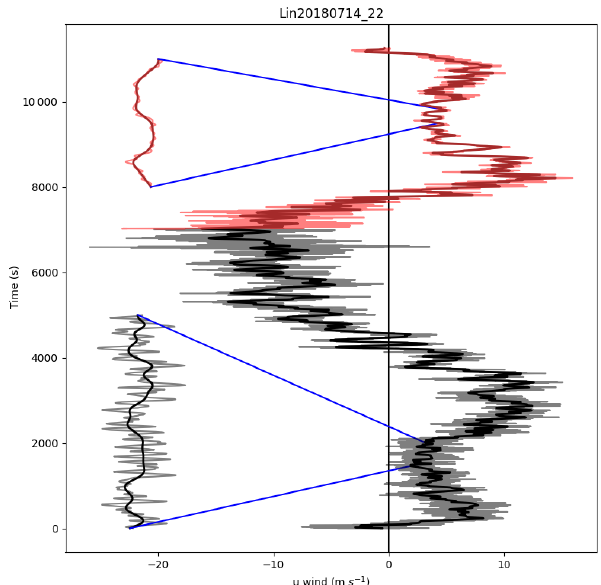
Figure 11. The raw (1s) data (pale line) and the filtered (bold line) u component as a function of time for ascent (black) and descent (red). This is for a launch from Lindenberg, including a parachute for the descent. Two sections are shown in more detail with the time axis scaled by